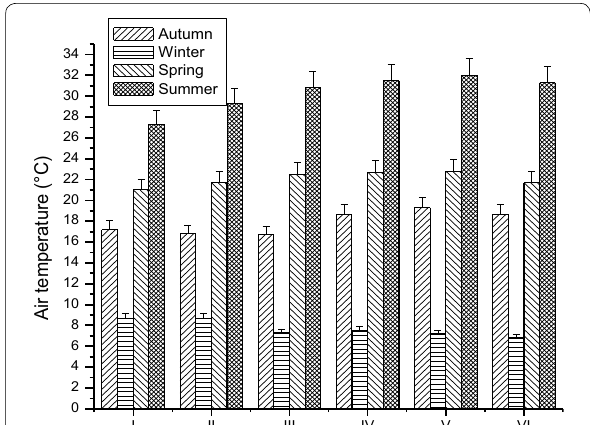
Fig. 2 Spatial and temporal variations of air temperature ( ° C) in